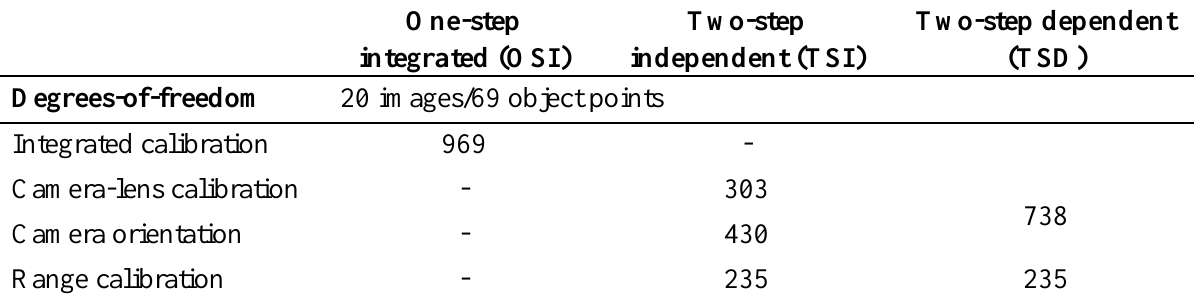
Table 3. SR4000 self-calibration precision statistical